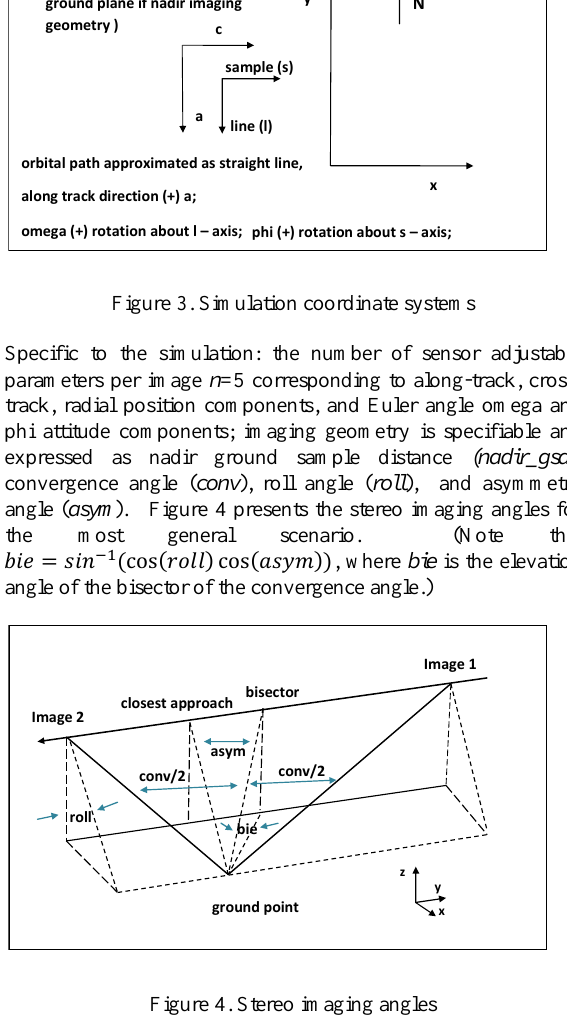
Figure 4. Stereo imaging angles Although not shown explicitly in Figure 4, imaging geometry includes the orientation of the actual image plane for each image. The (nadir) image plane is rotated about the x-axis (sample-axis) followed by a rotation about the resultant y-axis (line-axis) such that the sensor-to-ground point image ray intersects the principle point, i.e., the image focal axis “points” directly at the ground